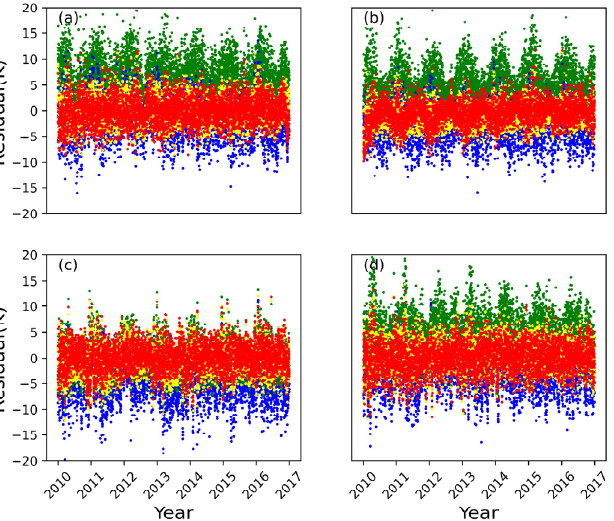
Figure 12. Residuals of the LSTM_Tm (red), RNN_Tm (yellow), BTm (green), and GPT3 (blue) models of four radiosonde stations in China from 2010 to 2016. ( a ) 52386, ( b ) 56146, ( c ) 57127, and ( d ) 51,828 stations.